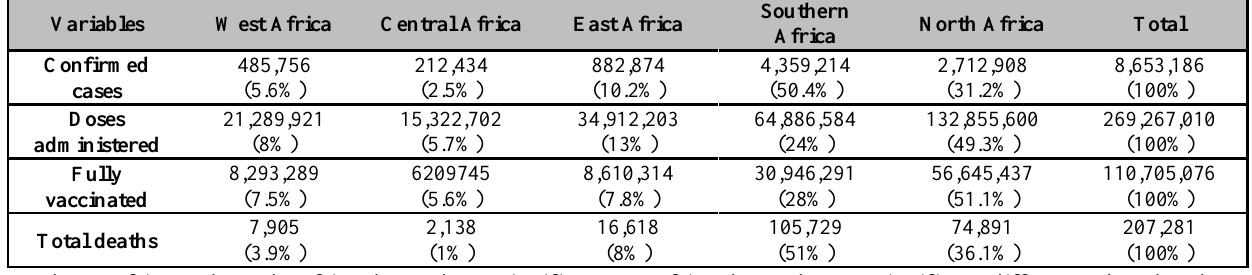
Table 1: Proportions of total confirmed cases, total doses of vaccine administered, total number of fully vaccinated people, and total number of deaths by region